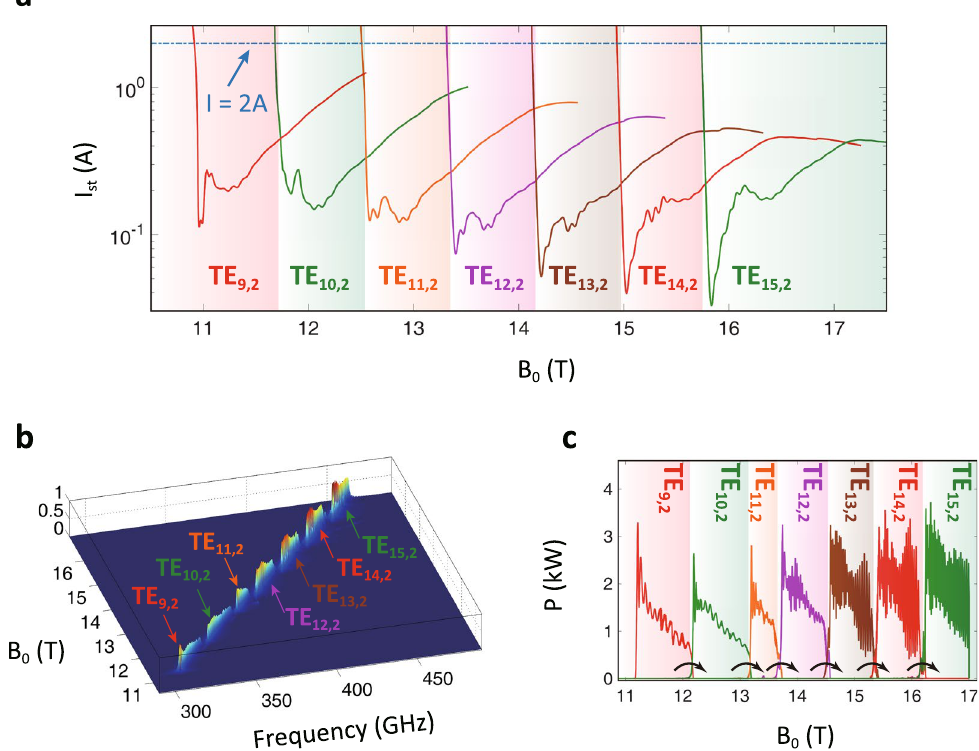
Figure 3. Multi-band radiation by mode switching. ( a ) The start-oscillation current curves of operating modes in different magnetic field strengths. The working current is selected as 2 A. ( b ) The frequency spectrum (Values in z axis represent the normalization of energy distribution) and ( c ) output power from the time-domain multi- mode